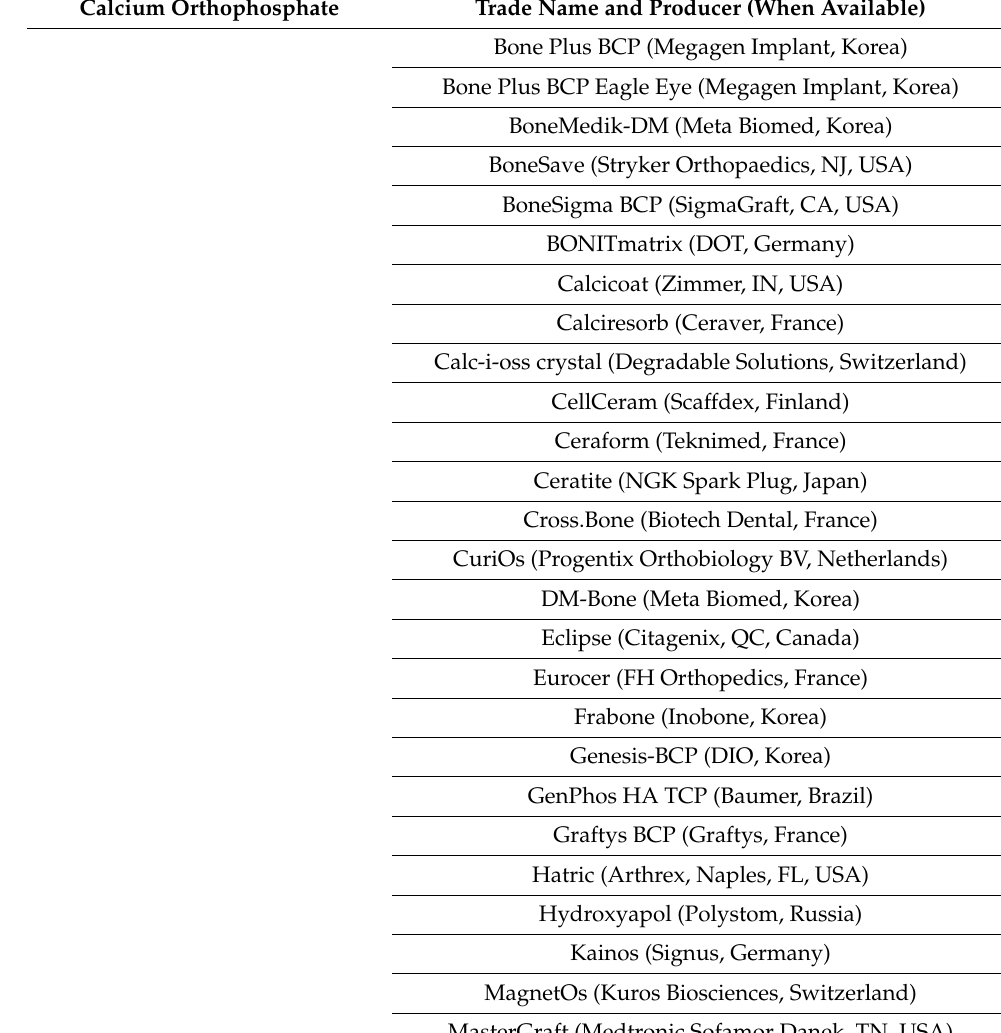
Table 3. Cont . Calcium Orthophosphate Trade Name and Producer (When